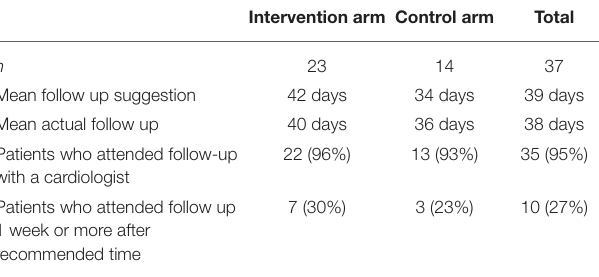
TABLE 4 | Patterns of cardiologist follow-up recommendations at the time of discharge and